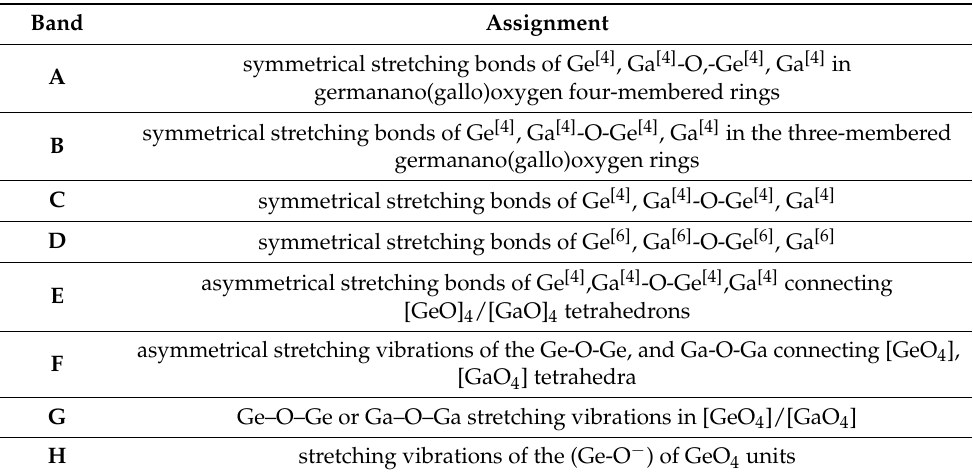
Table 2. Assignment of component bands in MIR spectra